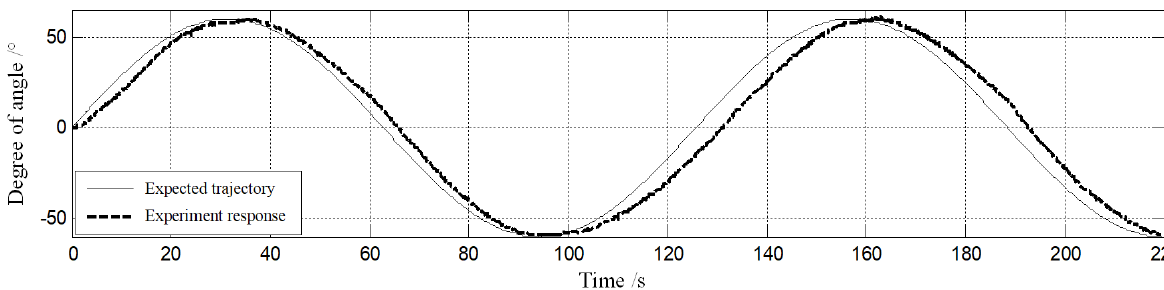
Figure 14. The expected trajectory and experiment response of the system.